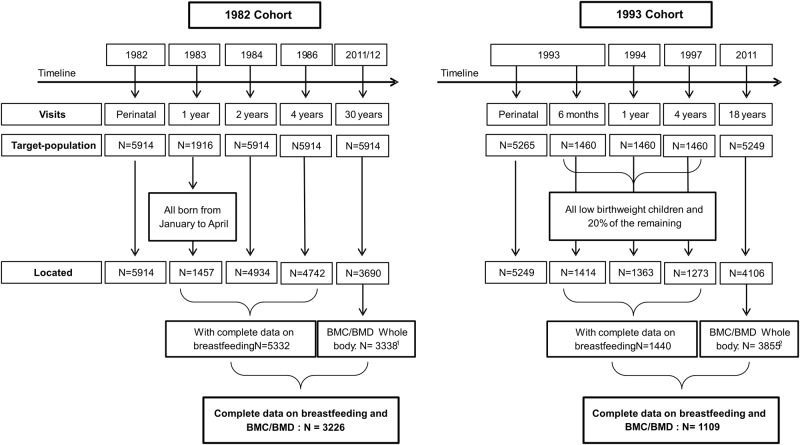
Description of the 1982 and 1993 Pelotas Birth Cohorts.1 Subjects excluded of DXA scan: pregnant or suspected pregnancy (n = 72); individuals in wheelchairs or with osteo-articular disabilities (n = 5); losses/refusals or subjects with wearing non-removable metallic objects (e.g. screws, earrings or piercings) or extremely obese individuals or those taller than 192 cm (n = 275); 2 Subjects excluded of DXA scan: pregnant or suspected pregnancy (n = 60); individuals in wheelchairs or with osteo-articular disabilities (n = 11); losses (n = 10); subjects with wearing non-removable metallic objects (e.g. screws, earrings or piercings) or extremely obese individuals or those taller than 192 cm (n = 105).